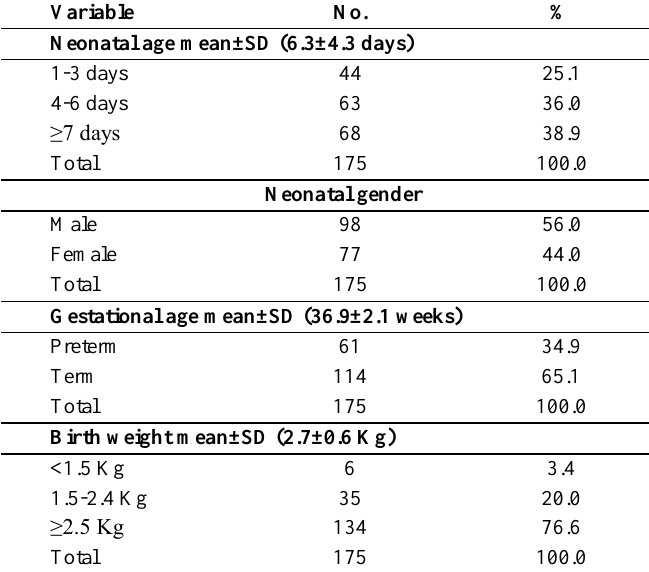
Table (3): Neonatal age, gender, gestational age and birth weight of